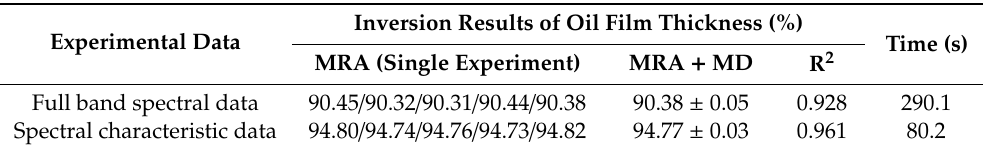
Table 5. Spectral feature filter experiment inversion results.